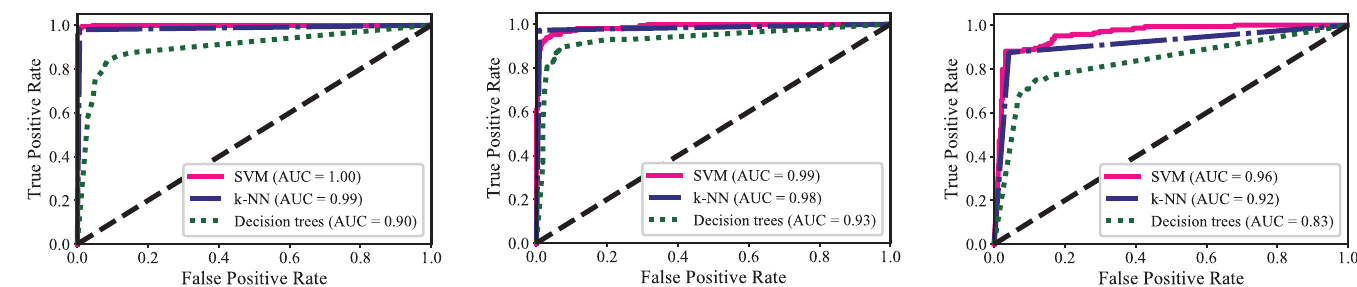
Fig 7. ROC curve and AUC values for three learning models using different feature extraction methods. Left: filter-bank; Middle: color coherence vector; Right: discrete cosine transform.